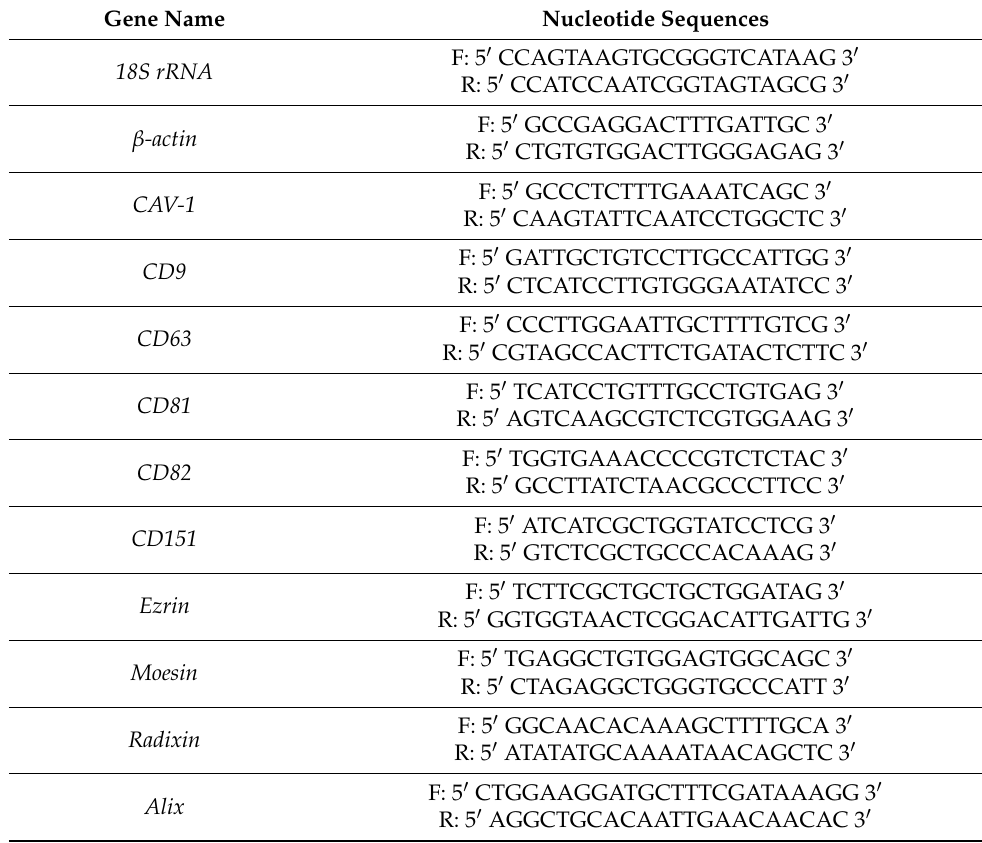
Table 1. List of primers used for